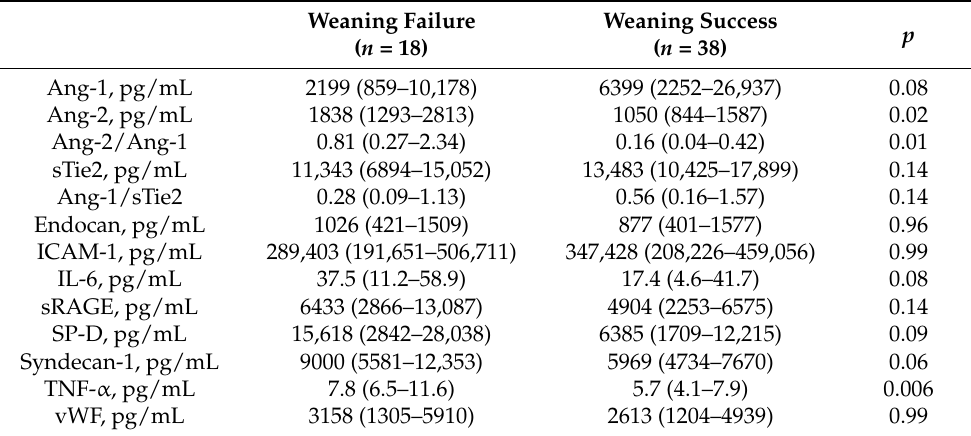
Table 2. Plasma biomarkers of endothelial/epithelial injury and inflammation.